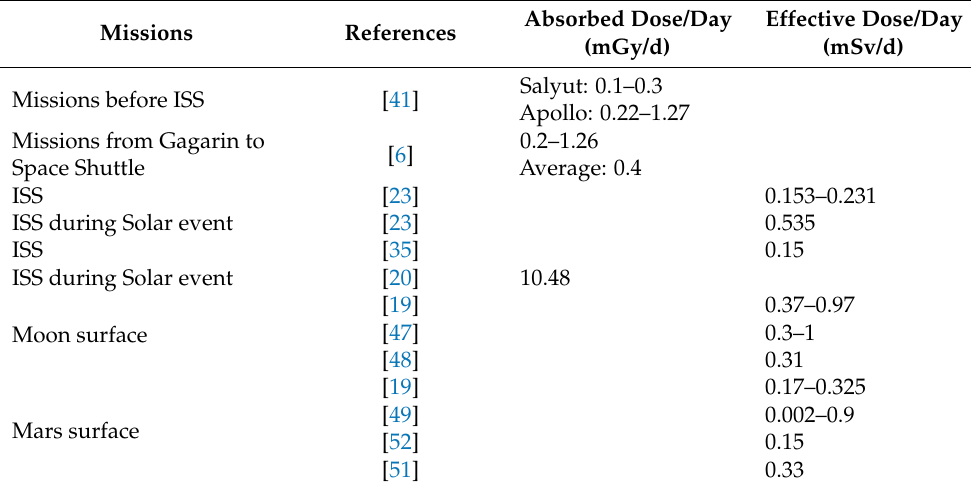
Table 1. Non-exhaustive list of reports about estimated doses of spatial interest.